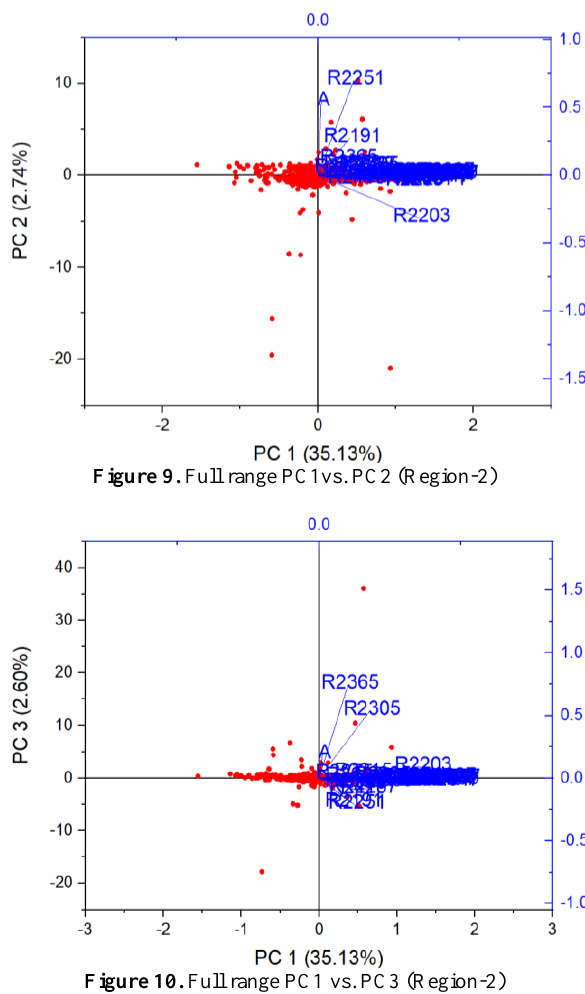
Figure 12. SHERLOC measurements for Sol 4 (Region-3) The SHERLOC Raman spectra for Region 3 recorded on Sol 4 are shown in Figure 12. This covers all the mineral features listed Figure 10. Full range PC1 vs. PC3 (Region-2) in Table 1 for the whole region of 240-360 nm. PC1 X Raman peaks for Region-2, recorded on Sol 4, exhibit features for minerals other than fluorescence (Figure 8). Here the minerals